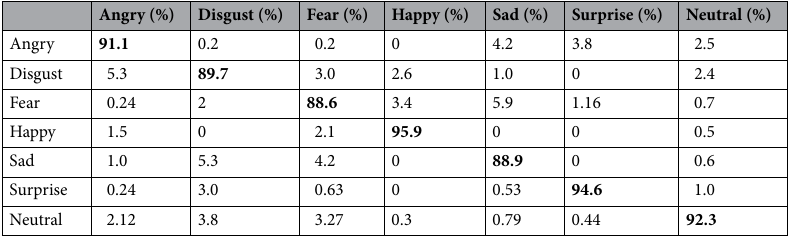
Table 2. Confusion matrix of 7 class facial emotion recognition results obtained by ConvNet with LBP on the FER2013 validation test dataset. Significant values are in